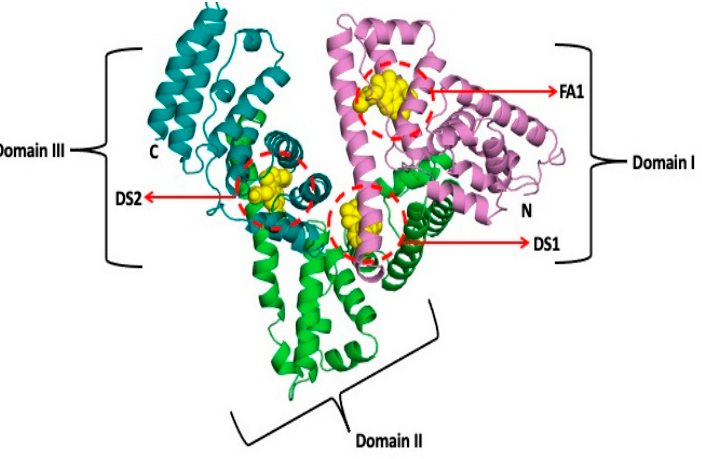
Figure 1. Three-dimensional structure of human serum albumin with drug and fa tt y acid binding